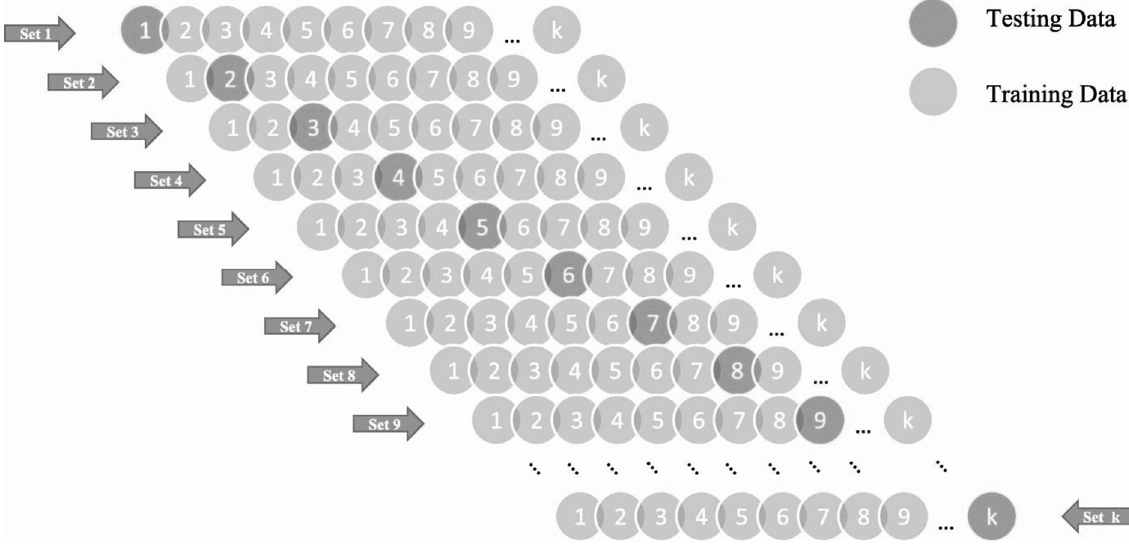
Figure 4. Flow diagram of K-Fold cross-validation algorithm.